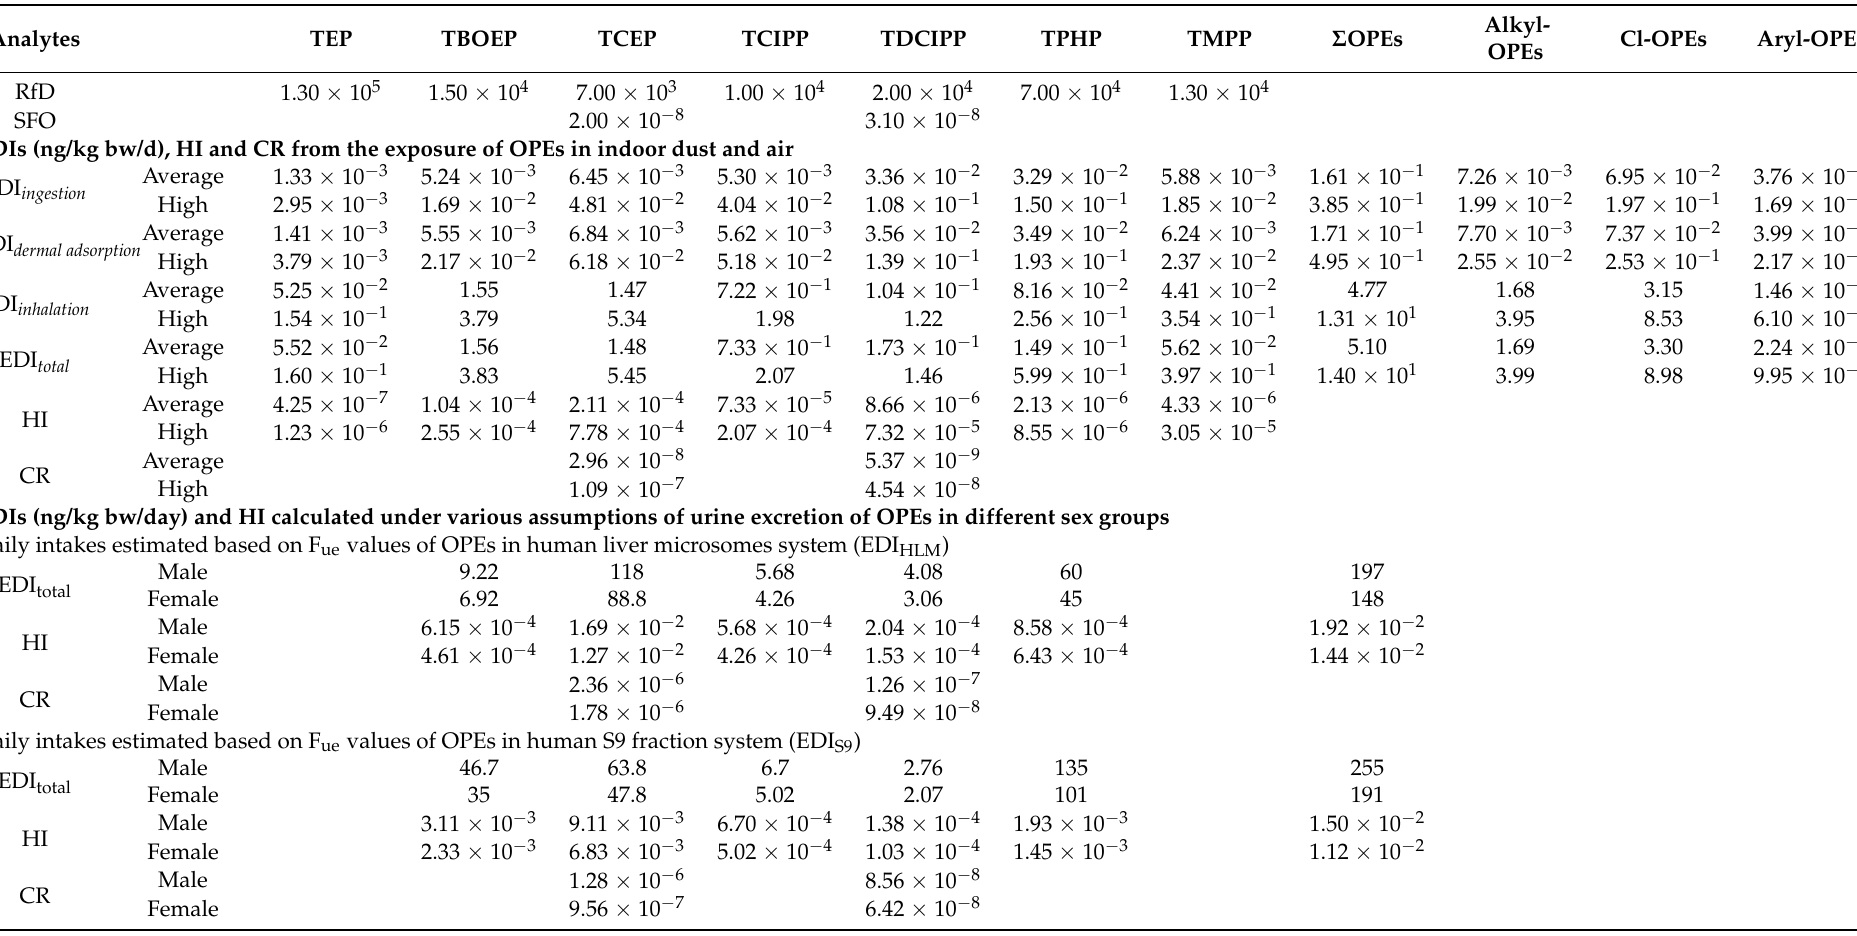
Table 1. EDIs (ng/kg bw/d), HI, and CR from the exposure of